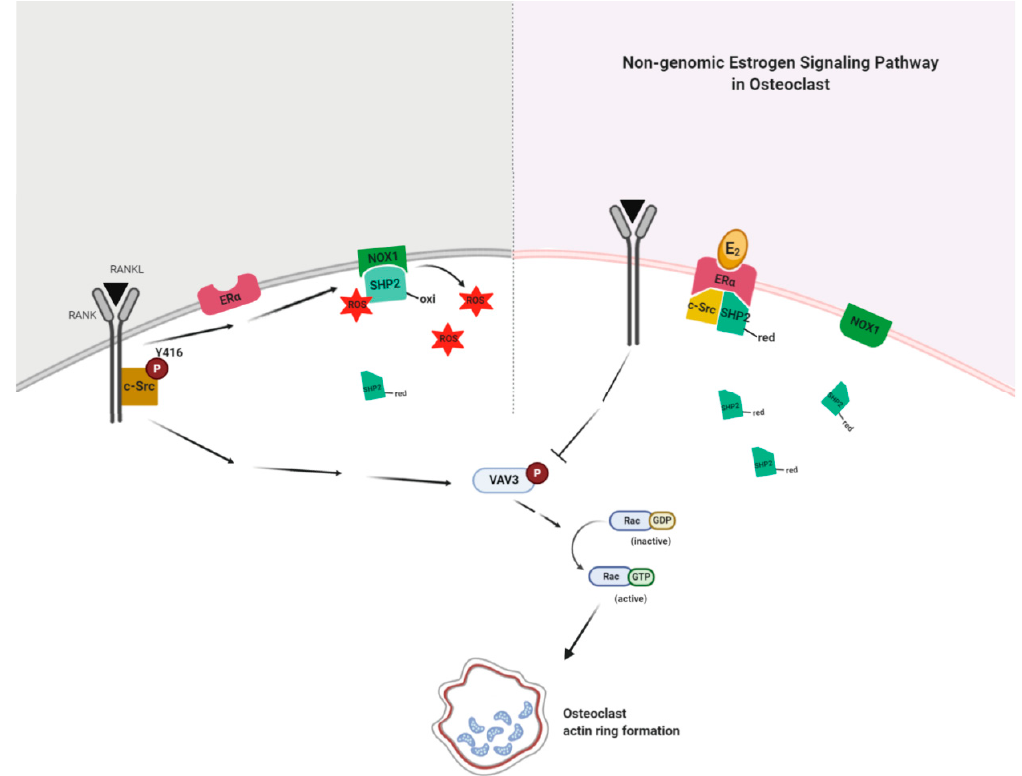
Figure 7. E 2 signaling plays a critical role in an impaired actin ring formation. RANKL activates c-Src and transmits a signal to generate reactive oxygen species (ROS) via NADPH oxidase 1 (NOX1), resulting in the association of NOX1 and the oxidized form (inactive) of c-Src homology 2 (SH2)-containing protein tyrosine phosphatase 2 (SHP2) to decrease the availability of the reduced (active) form of SHP2. E 2 binding to ER α forms a complex with active SHP2 and c-Src to attenuate RANKL-stimulated c-Src activation due to increased availability of the reduced form of SHP2 through the decreased interaction between NOX1 and the oxidized form of SHP2 in a non-genomic way. Dephosphorylation of c-Src is followed by the blockade of Vav3 and Rac1 activation by RANKL stimulation. This results in impaired actin ring formation in OCs and, therefore, reduced bone